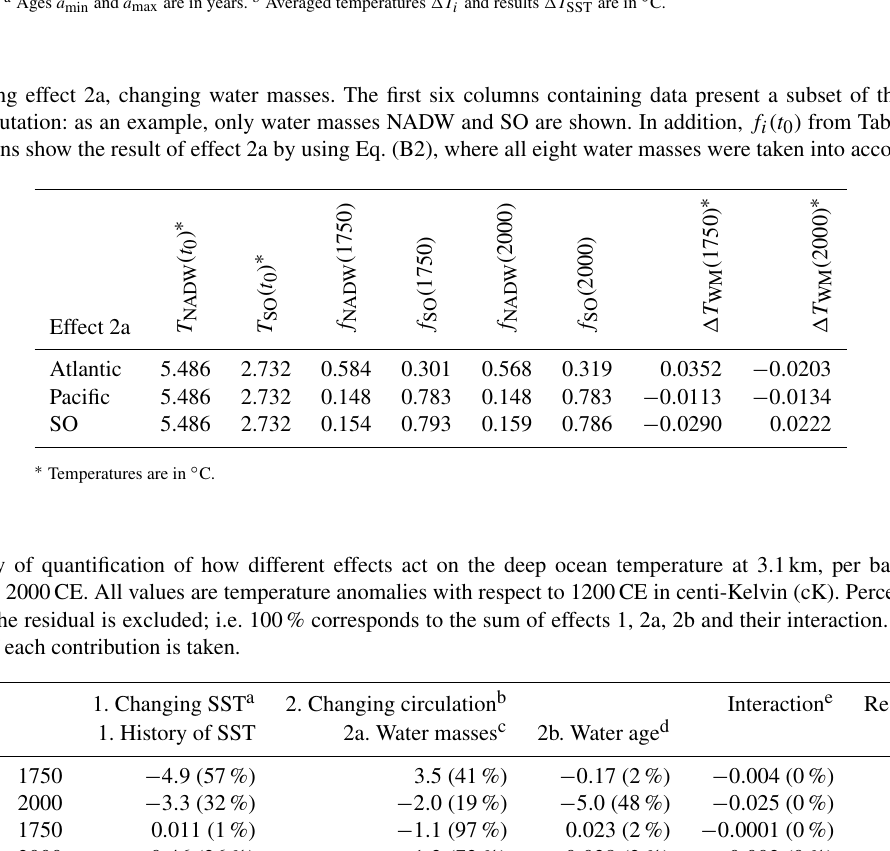
a Results are taken over from Table B1 and converted to cK. b Changing circulation consists of the – not necessarily independent – subeffects 2a and 2b. c Results are taken over from Table B2 and converted to cK. d The water-age contribution follows from Eq. (B3). e The interaction is the cross term of deviations between effect 1 and 2a and follows from Eq. (B4). f The residual equals the total minus effects 1, 2a, 2b and the interaction. It represents unaccounted effects and uncertainties in the calculations. g The total of all effects is given by the model output (cid:49)T := T ( t ∗ ) − T ( t 0 ) of OcTRA, which is averaged at 3.1km within the basin of